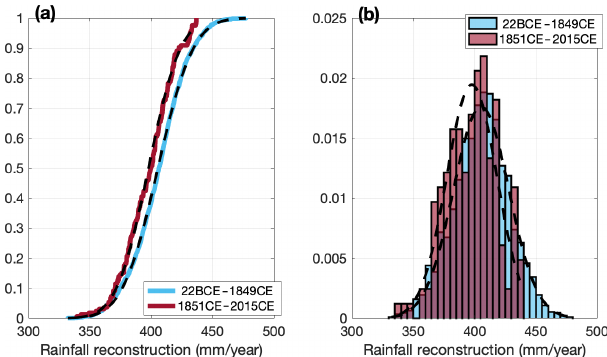
Figure 4. (a) Empirical distribution function plot for rainfall recon- struction samples from 22BCE to 1849CE (blue curve) and from 1851 to 2015CE (red curve). (b) Probability density function scal- ing histogram for two samples. The black dashed curves are each sample’s corresponding normal